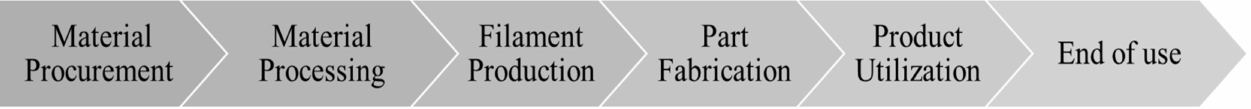
Figure 9. The life cycle of a fused filament fabrication (FFF) build